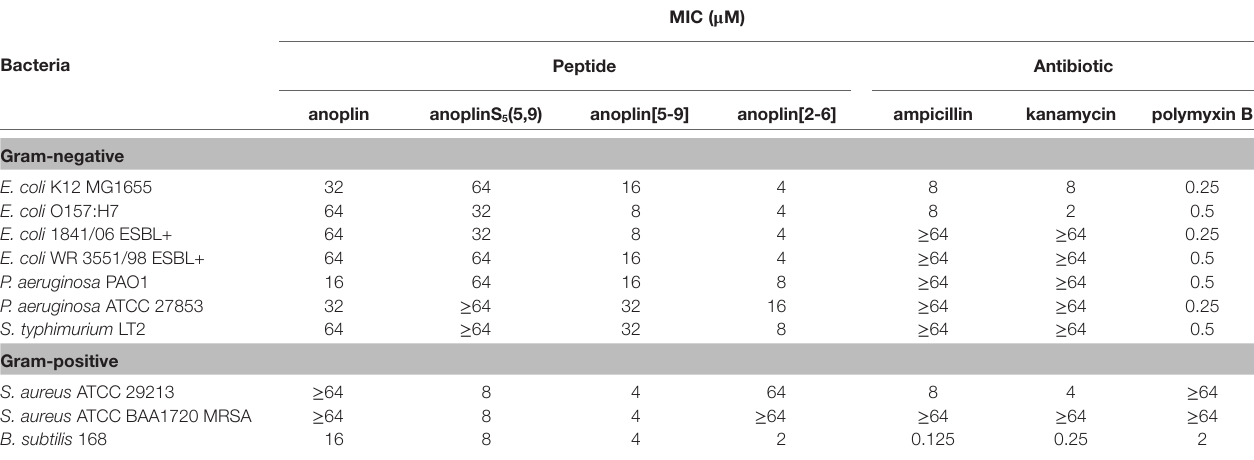
TABLE 2 | Minimum inhibitory concentration (MIC) of anoplin analogs against different Gram-negative and Gram-positive strains.